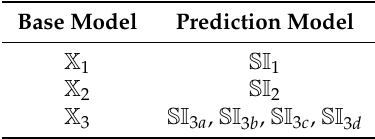
Table 4. Specification of the training data fed to each